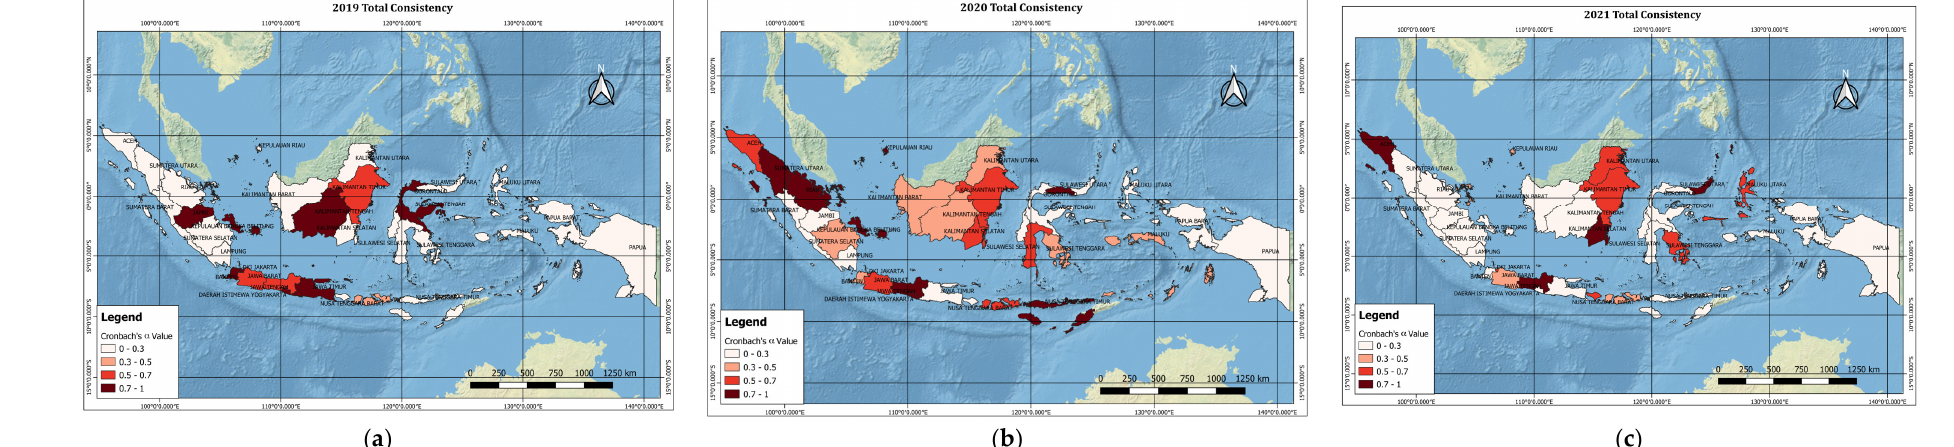
Figure 3. Data consistency figure from 2019–2021: ( a ) 2019; ( b ) 2020; ( c ) 2021.